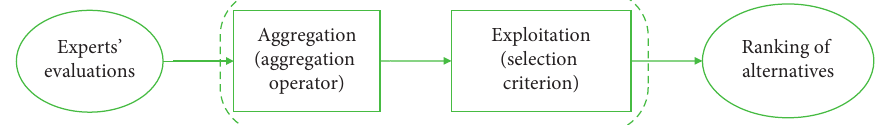
Figure 1: The consensus reaching process.